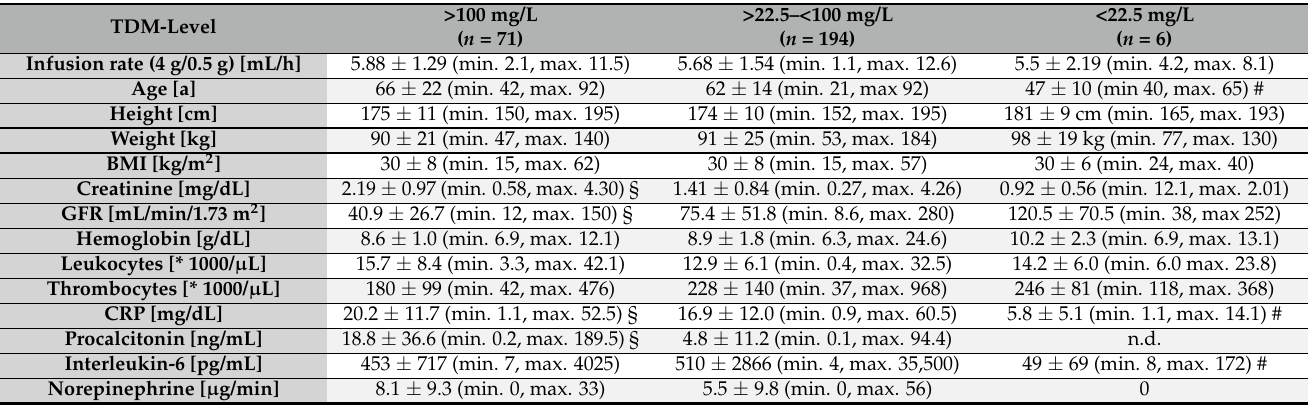
Table 1. Patient characteristics, clinical, and laboratory parameters of the piperacillin level monitored patients. Data are presented as mean values. p ≥ 0.05 was considered as statistically significant. # shows significant difference between the target attainment group ( n = 194) vs. the sub-therapeutic group ( n = 6). § shows significant difference between the target attainment group vs. the potentially toxic group exceeding 100 mg/L ( n = 71).* sign is for